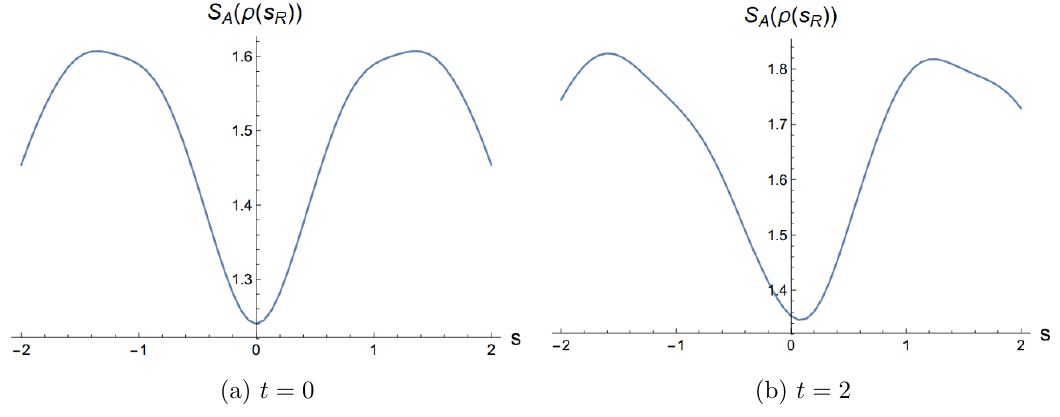
Figure 15. The entanglement entropy of region A as a function of the modular parameter s R . (a) t = 0 (before the quench). (b) t = 2 (after the